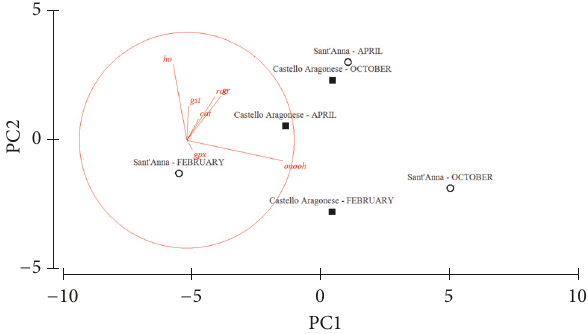
Figure 3: Separation of Platynereis spp. populations (white circles = Sant’Anna; black squares = Castello Aragonese) and periods of sampling obtained by principal component analysis (PCA) of mean biological